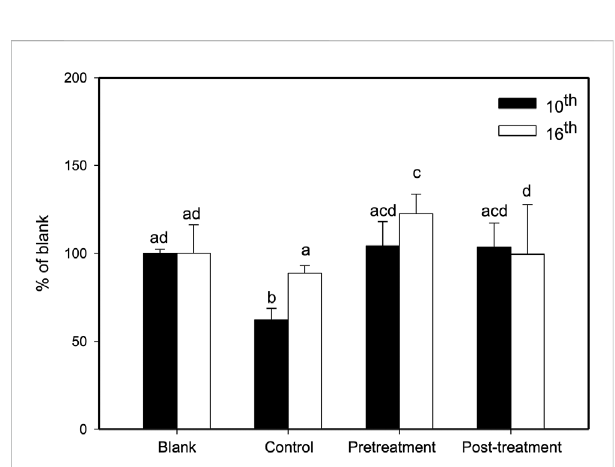
FIGURE 4 Effects of XSLJZT on paclitaxel-induced leucopenia in mice on days 10 and 16. Results are presented as the mean ± S.D. The different alphabetsshow asigni fi cant( p <